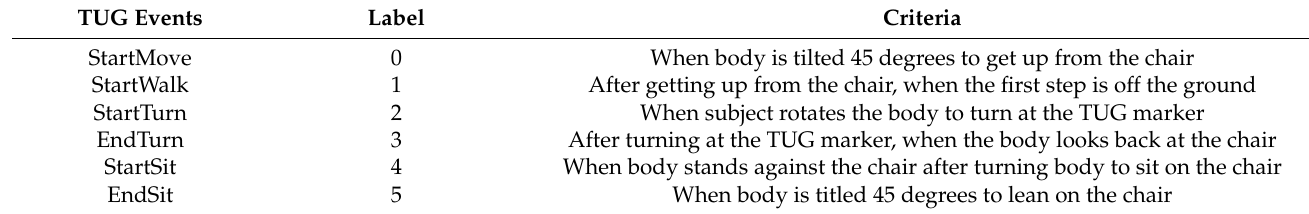
Figure 2. Overall flowchart of the proposed method. Table 1. Labeling guidelines for six